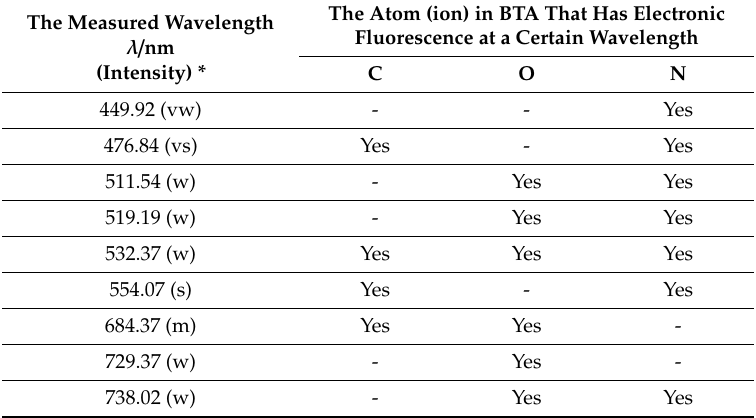
Table 9. Systematization of spectral lines of electronic laser fluorescence of BTA atoms (ions). The Measured Wavelength λ / nm (Intensity)